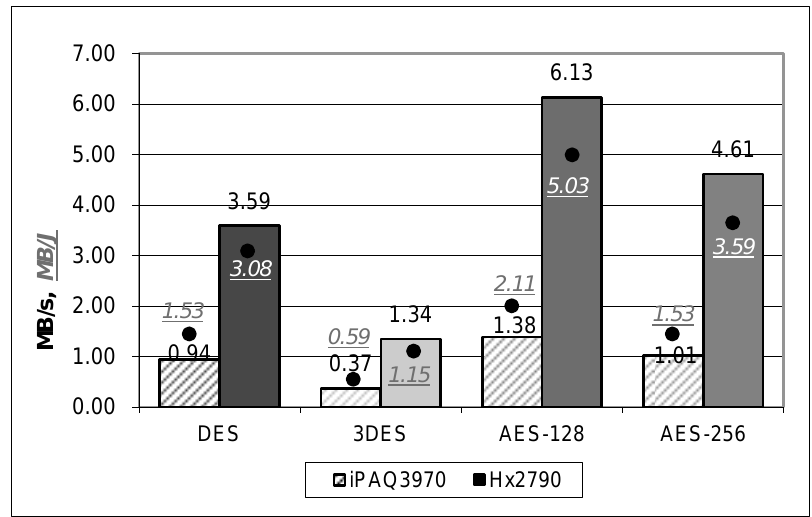
Figure 2. Throughput (represented with bars) and Energy Performance (represented with dots) of block